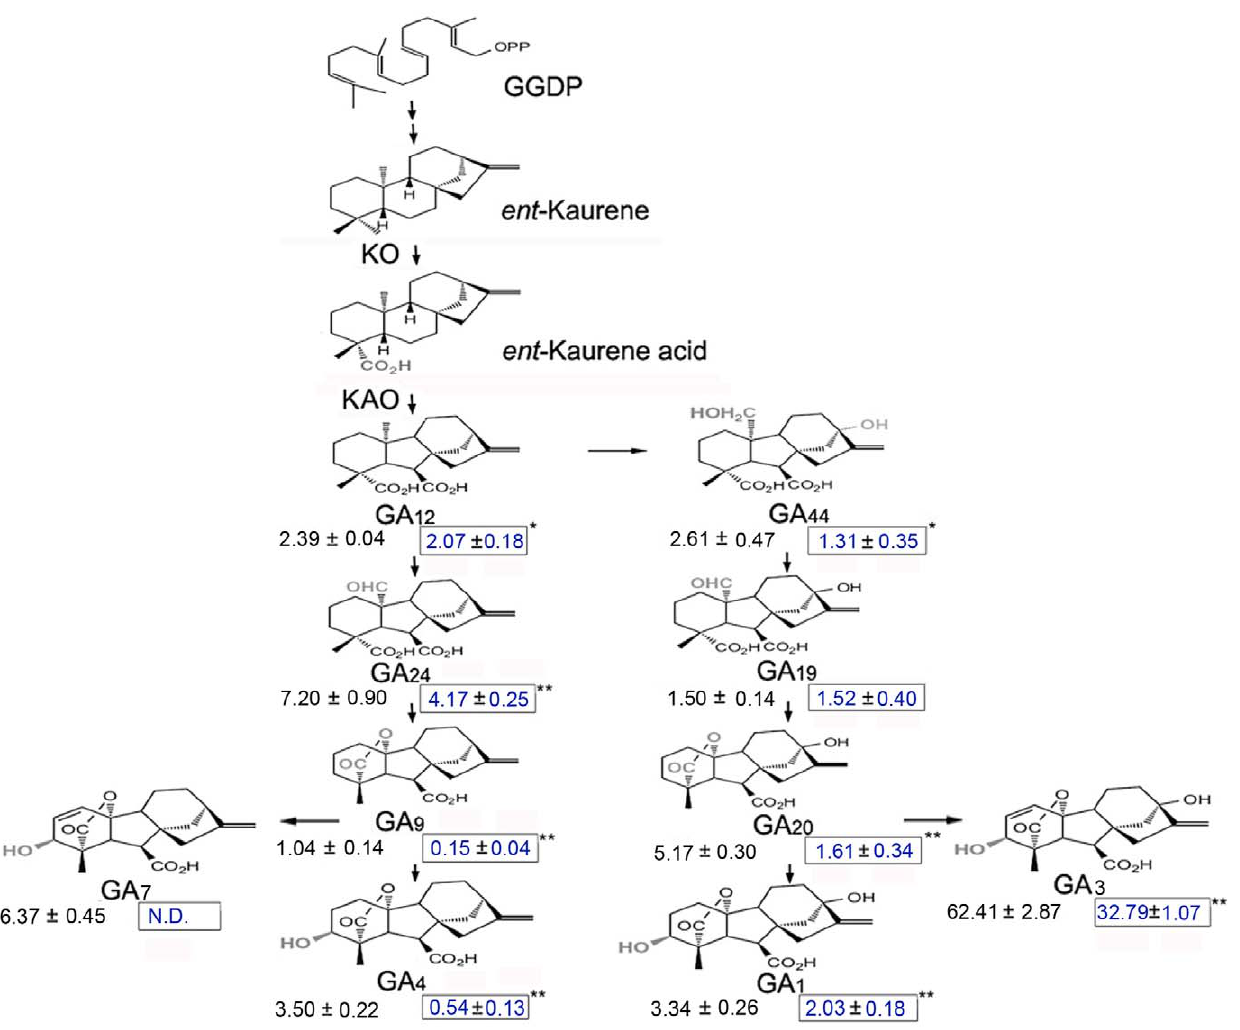
Figure 3. Endogenous GAs level in the WT (left) and sck1 (right, boxed). Catkins were gathered in the formation of the primordium of the floral cluster, and the endogenous GAs were determined by LC/MS. N.D., not detected due to low abundance; one asterisk indicates significant difference at P , 0.05 compared with the wild type and two asterisk indicates significant difference at P , 0.01. Data are means 6 SD from three trials (ng/g fresh weight).